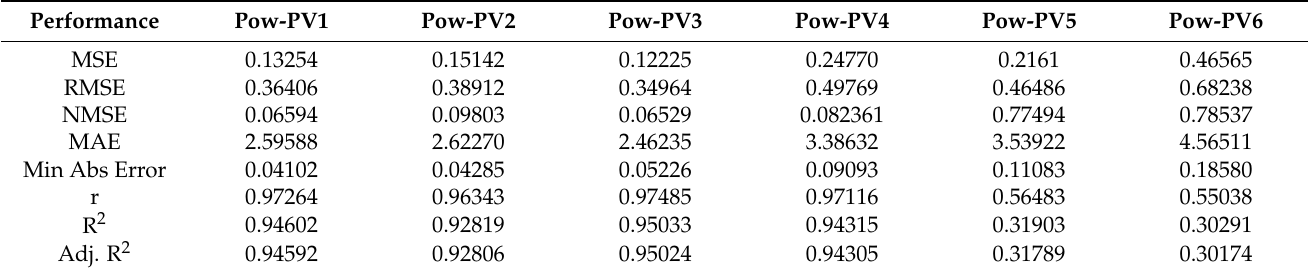
Table 6. Comparison results using different performance indicators.